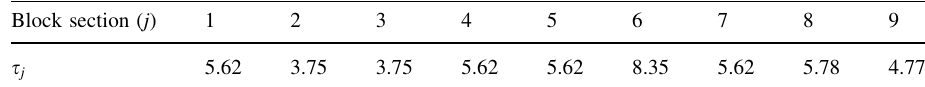
Block section ( j )